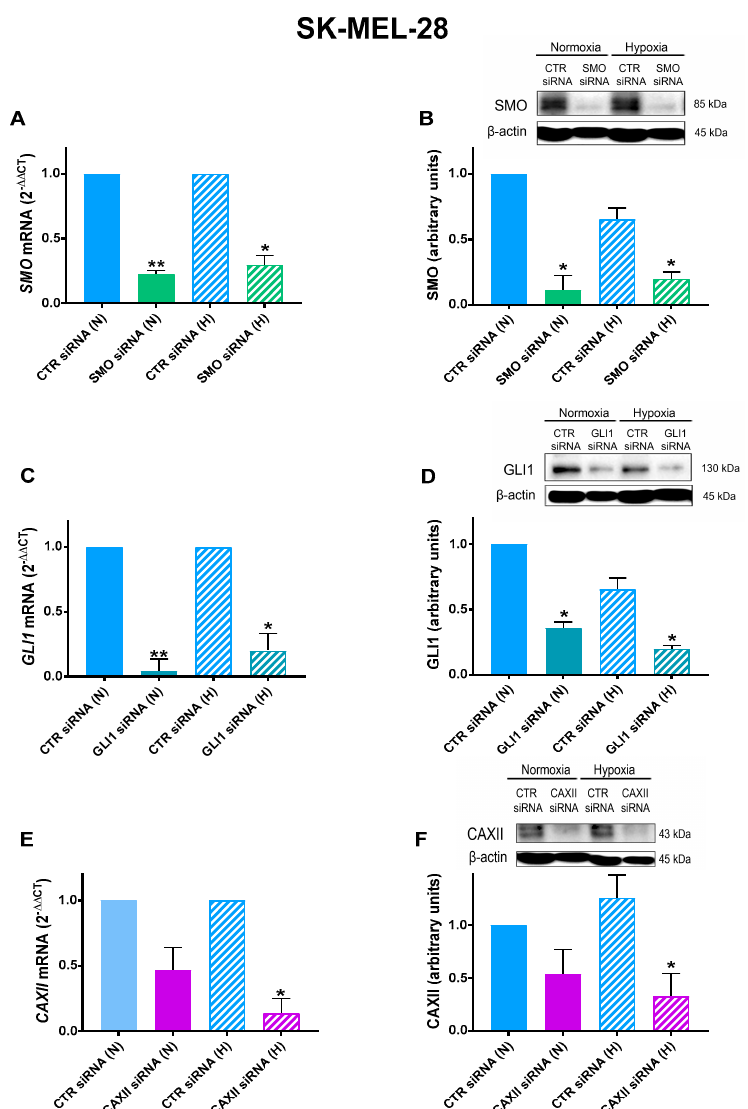
Figure 2. SMO, GLI1, and CAXII transient knockdown in SK-MEL-28 cell line: SMO ( A , B ), GLI1 ( C , D ), and CAXII ( E , F ) mRNA as determined by RT-qPCR and western blot analysis in SK-MEL-28 silenced by siRNA under normoxic (N) or hypoxic (H) conditions. β -actin was used as loading control for western blot, and L32 was used as housekeeping gene for RT-qPCR. Blots are representative of three independent experiments. Means ± SEM are presented. (n = 3; * p ≤ 0.05 and ** p ≤ 0.01 indicate statistically significant differences).